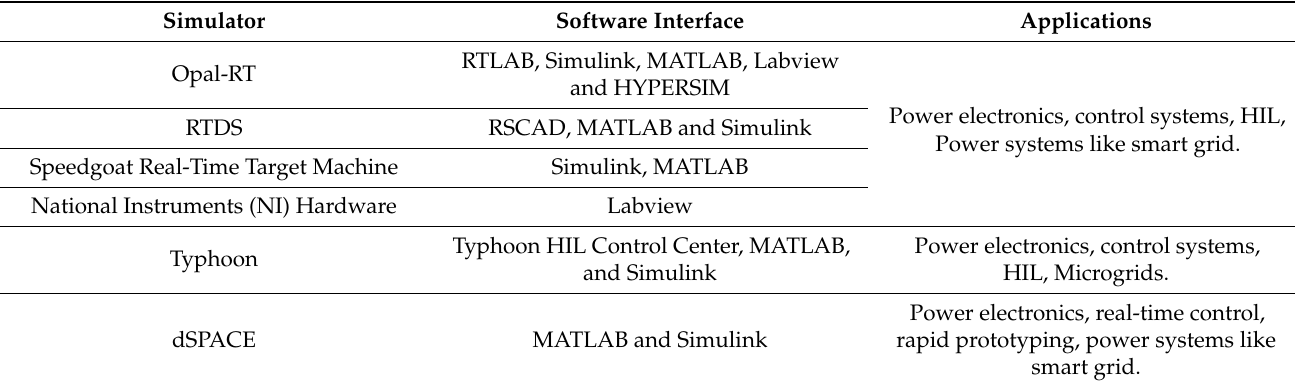
Table 2. Real-time simulators for PHIL testing of multiple applications. Modified from